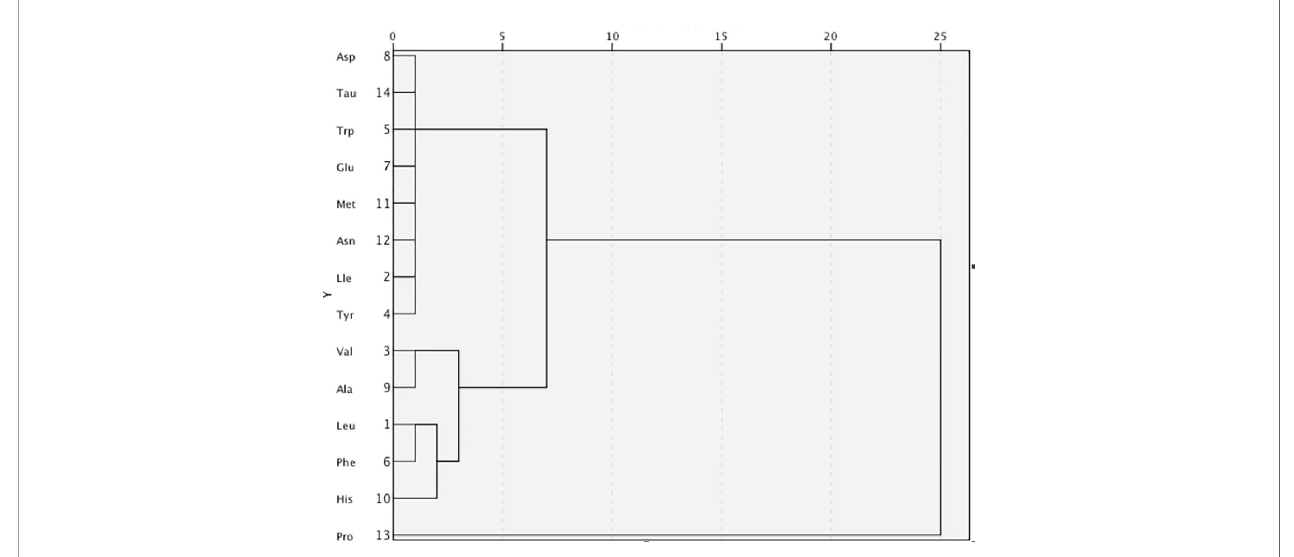
FIGURE 2 | The side dendrogram represents the hierarchical clustering of the 14 amino acids based on Pearson correlation, and we can see a strong correlation with the amino acids. Ile, isoleucine; Leu, leucine; Val, valine; Tyr, tyrosine; Trp, tryptophan; Phe, phenylalanine; Glu, glutamic; Asp, aspartic; Ala, alanine; His, histidine; Met, methionine; Asn, asparagine; Pro, proline; Tau,